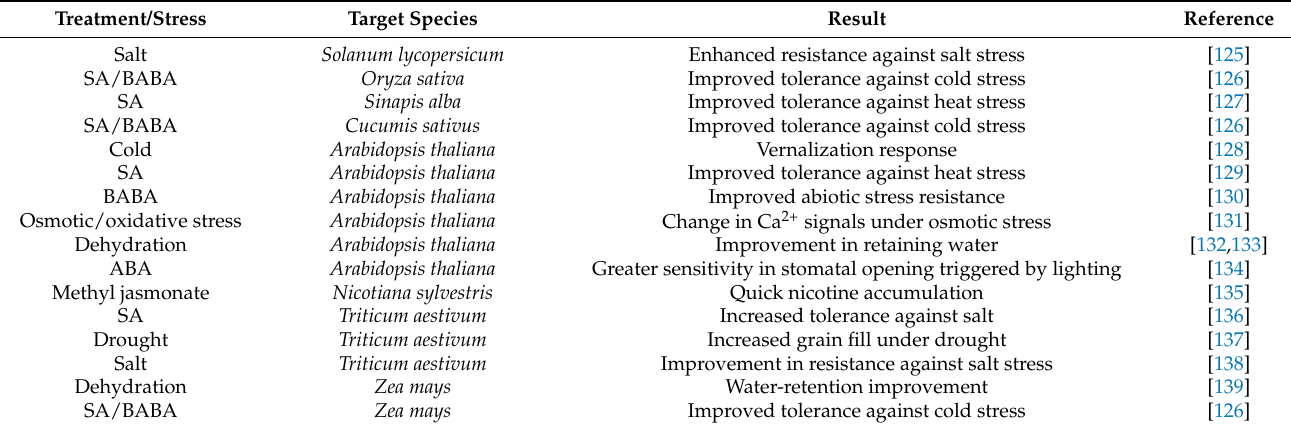
Table 3. List of stress priming in diferent species of